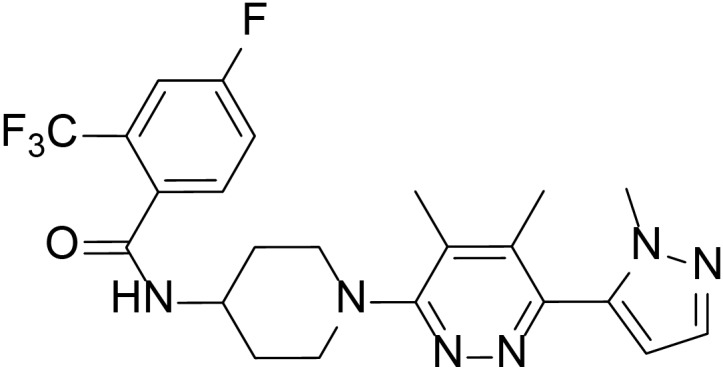
Structure of L-4.